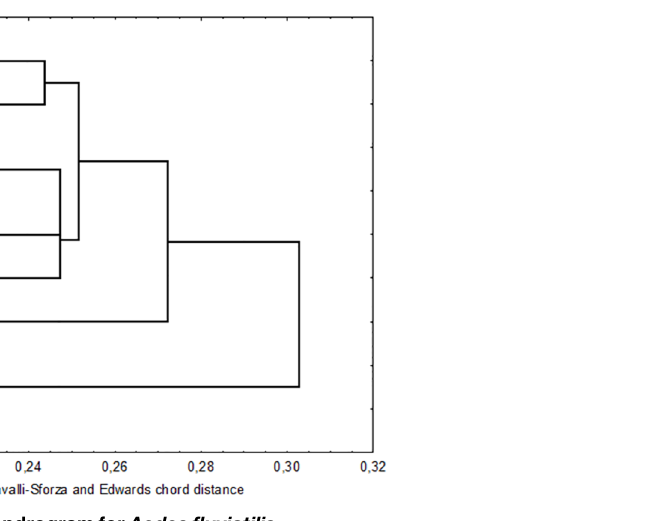
Fig 2. Genetic-distance dendrogram for Aedes fluviatilis